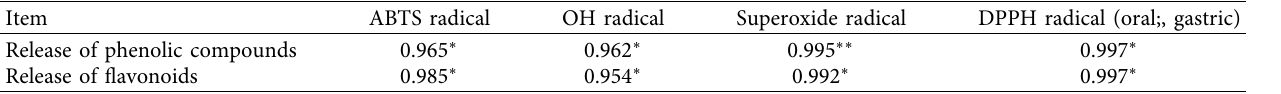
Table 1: Correlation analysis between the release of total phenolic compounds or total flavonoids and antioxidant activities of the RTBC.